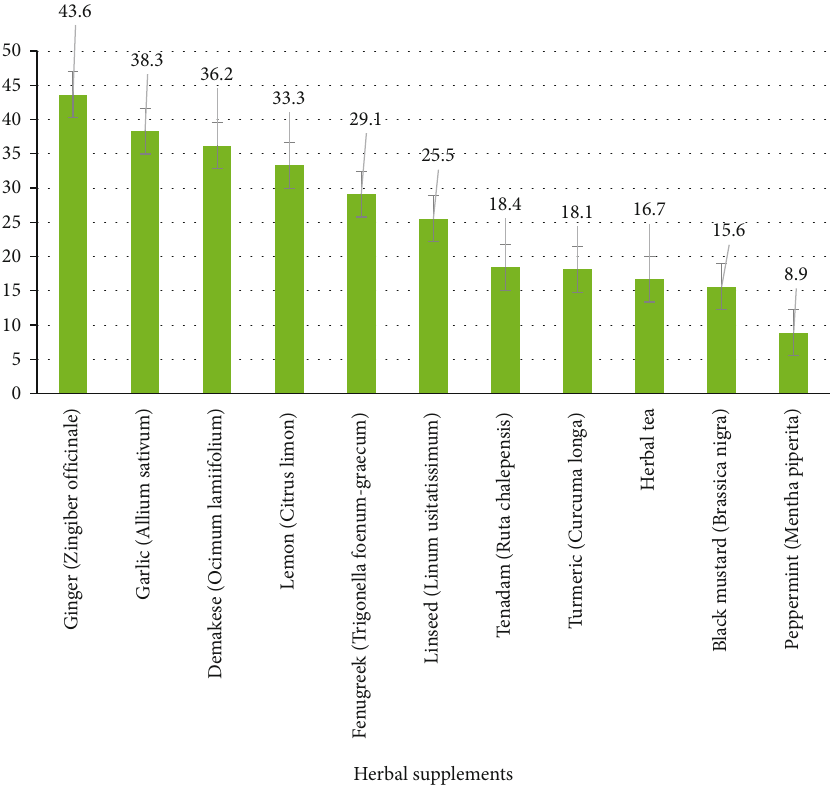
Figure 2: Frequency (%) and list of herbal supplements used during